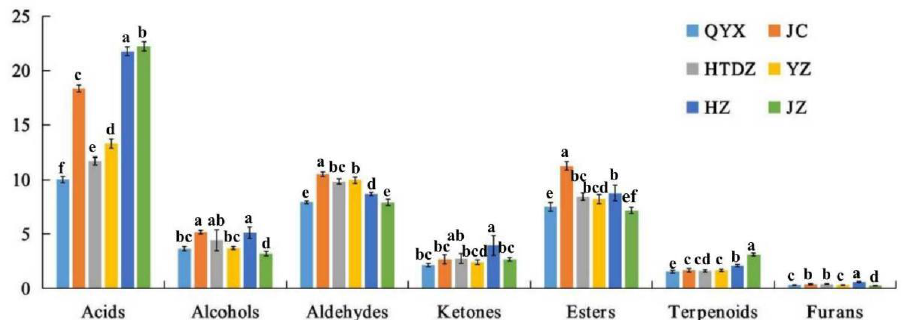
Figure 3. Semi-quantitative results of GC-IMS analysis of the volatiles in six red jujube cultivars taken from Xinjiang Province, China (Jinchang—‘JC’, Junzao—‘JZ’, Huizao—‘HZ’,Qiyuexian—‘QYX’, Hetiandazao—‘HTDZ’, and Yuanzao—‘YZ’). Lower letters (a–f) correspond to significant differences at p < 0.05.